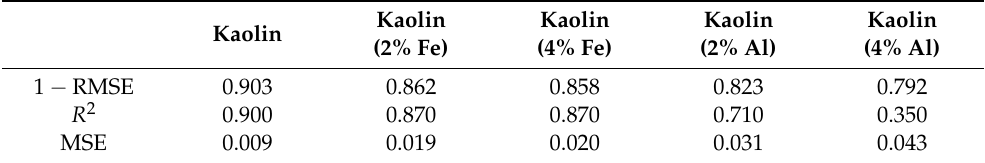
Table 6. ANN regression similarity measurements of FR using leachate parameters of clay soil samples.